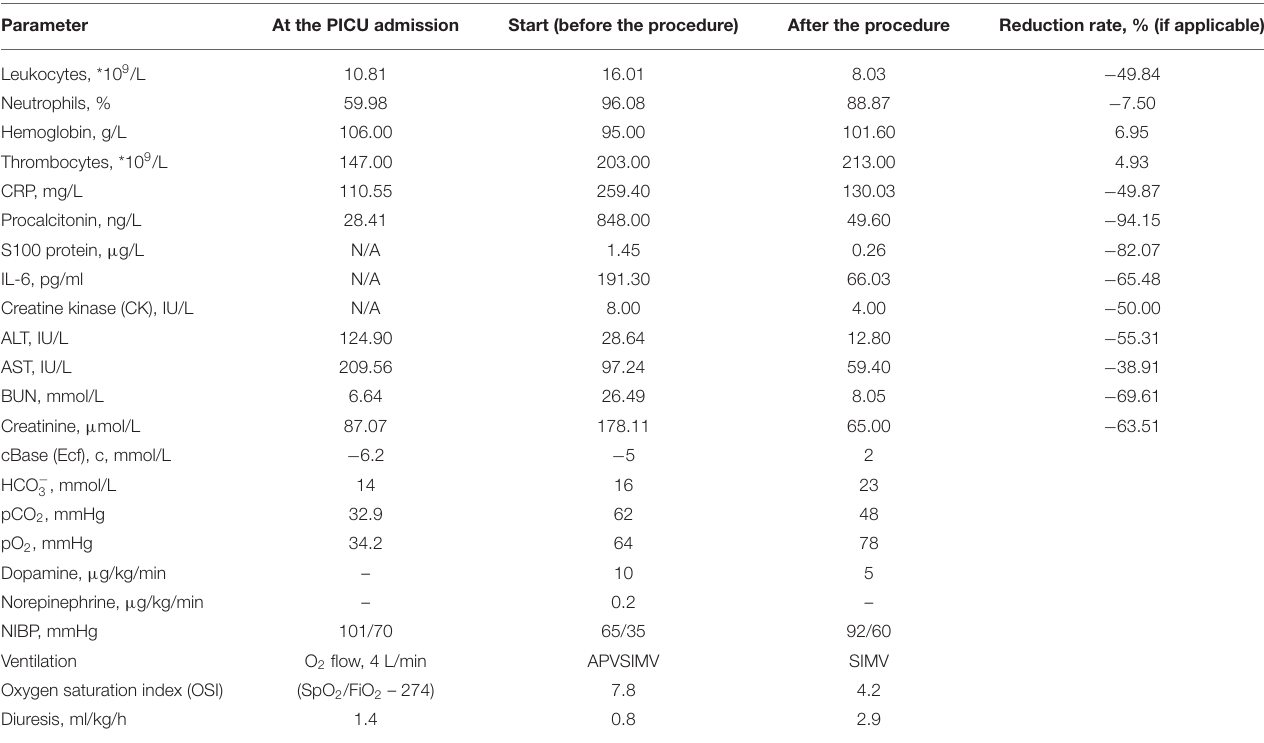
TABLE 3 | Main clinical and laboratory parameters (patient 3). Parameter